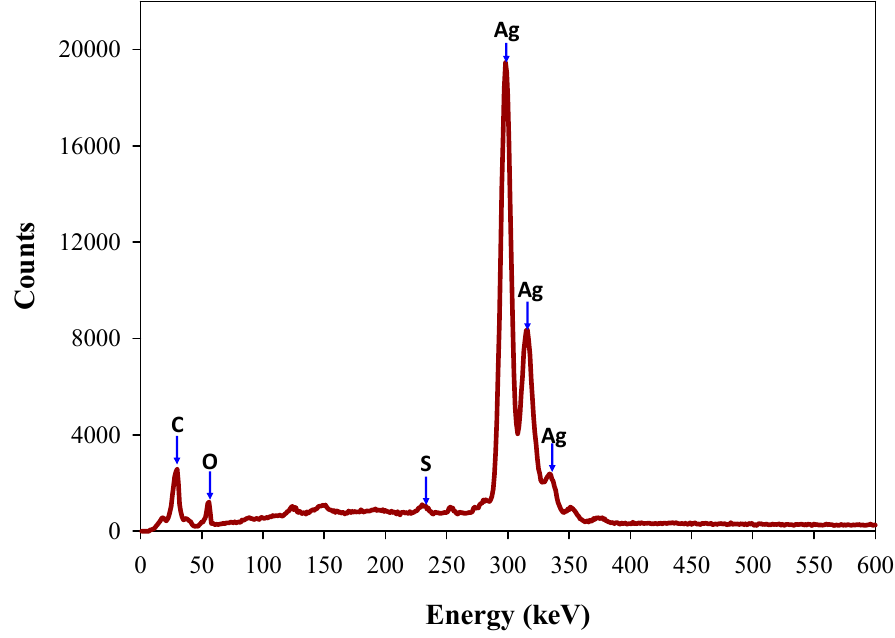
Figure 7. Energy dispersive spectroscopy (EDS) analysis of Ta-AgNPs synthesized under optimized conditions.